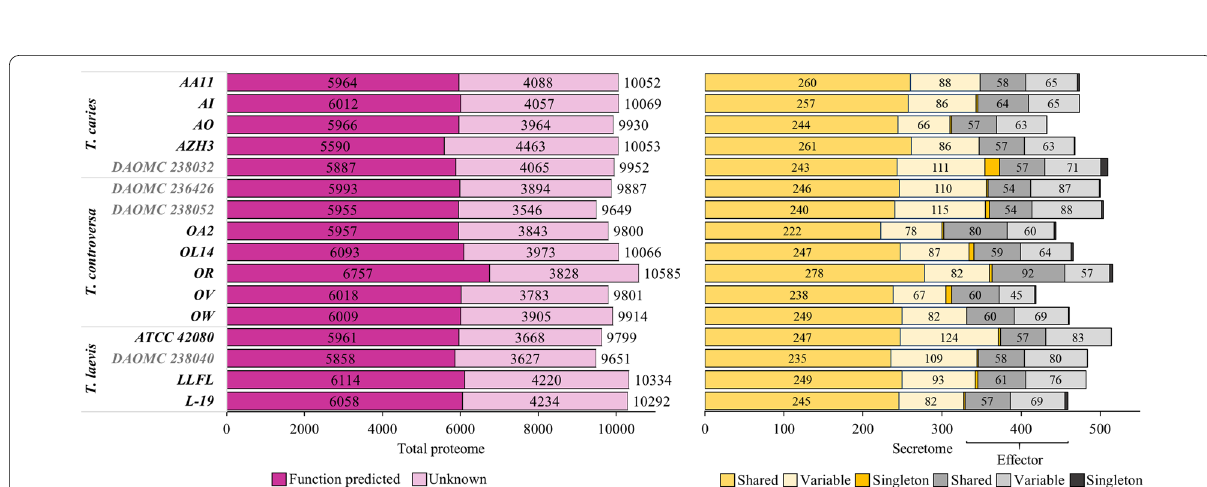
Fig. 5 In silico functional genomic prediction. A: Stacked histograms of functional annotation results of each genome. B: Total predicted secretome and effectors and their distribution in different orthology clusters at the interspecies level. Shared fraction refers to the secreted proteins and effectors which are shared between all 16 isolates. Variables are represented in an absent-present manner in different genomes. Secretome and effectors detected in singletons are isolate specific. Values shown are the total numbers of